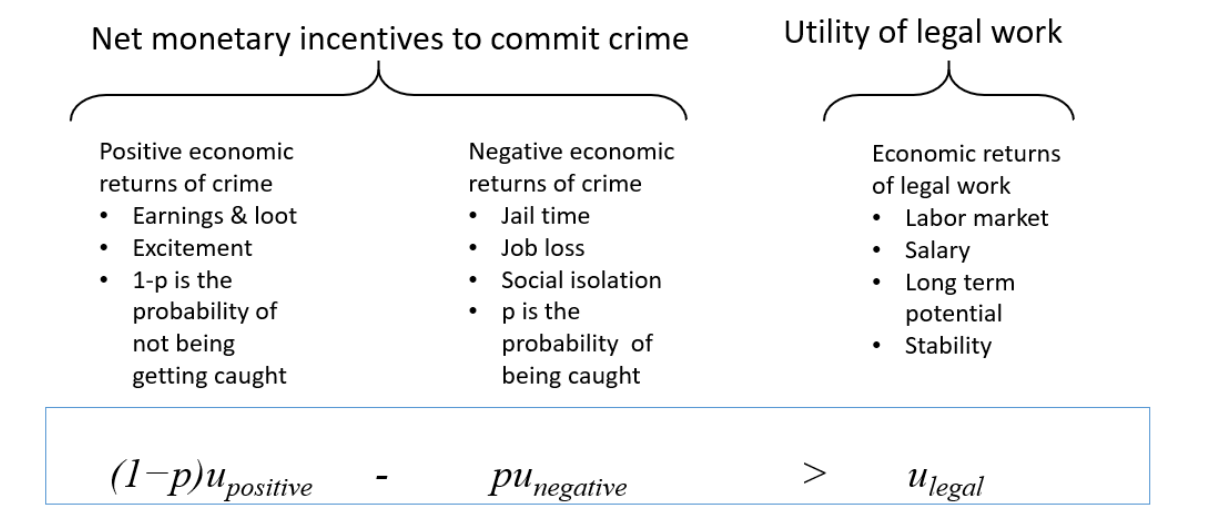
Figure 1. The Becker crime utility